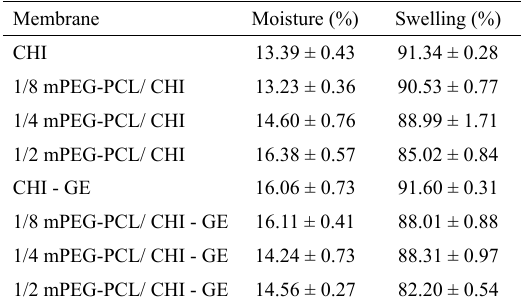
Table 4. Moisture content and percentage of swelling of membranes unloaded and loaded with